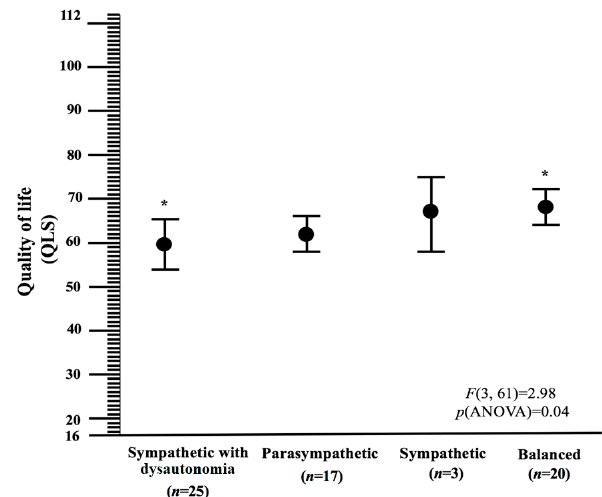
Figure 2. Quality of life in each profile (mean ± 95% Confidence interval, n = 65). One-way analysis of variance; common asterisk indicates significant differences between profiles in post-hoc comparisons. The analyses were not corrected for multiple comparisons. QLS, Quality of Life Scale (higher scores mean better quality of life).